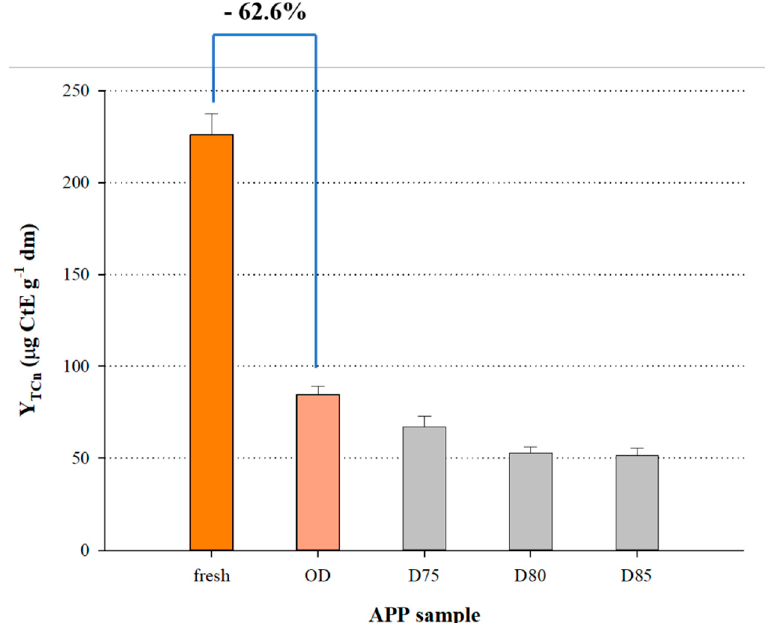
Figure 4. Bar plot showing the effect of APP drying under optimised conditions on the yield of total carotenoid recovery, as compared with the non-dried APP and APP dried at elevated temperatures. Assignments: OD, optimal drying ( t = 8.27 h and T = 70 °C). D75, D80 and D85 correspond to APP drying at 75, 80 and 85 °C, for t = 8.27 h).